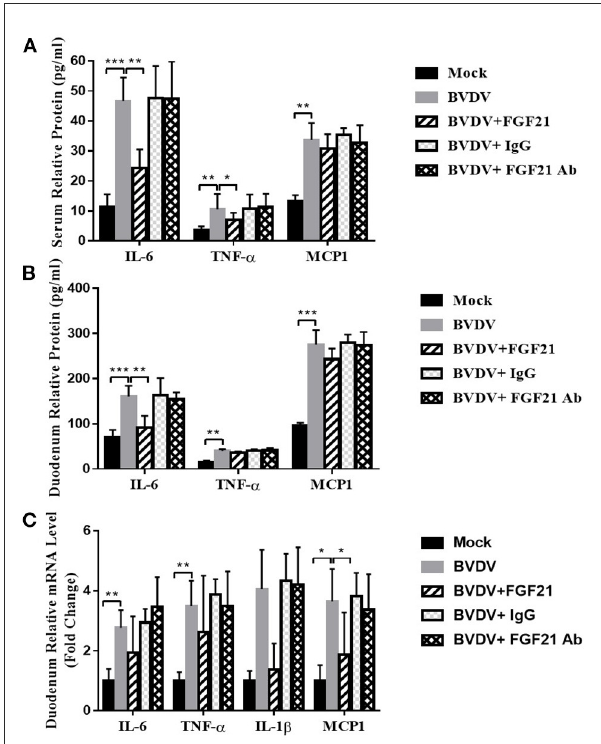
FIGURE6 Mouse plasma and duodenum levels of inflammatory cytokines. (A, B) Inflammatory cytokine levels in the plasma (A) and the duodenum (B) . (C) Inflammatory cytokine mRNA levels in the